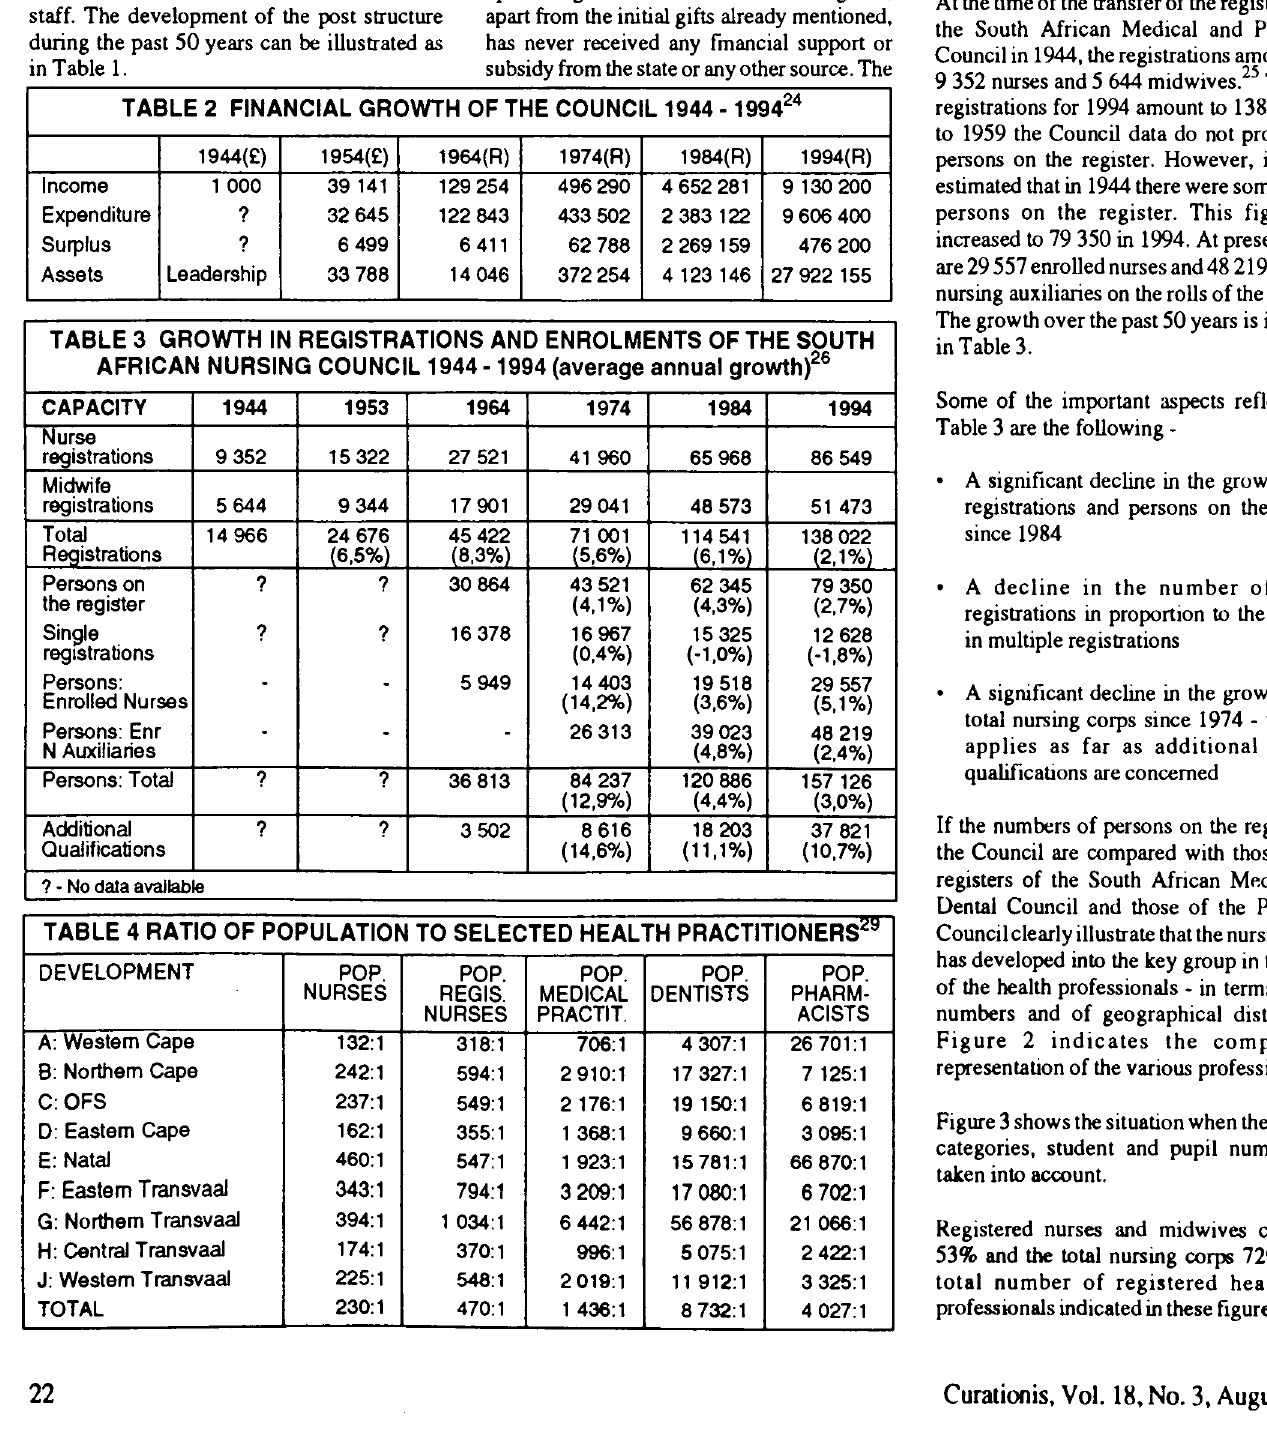
TABLE 2 FINANCIAL GROWTH OF THE COUNCIL 1944 -1994^^